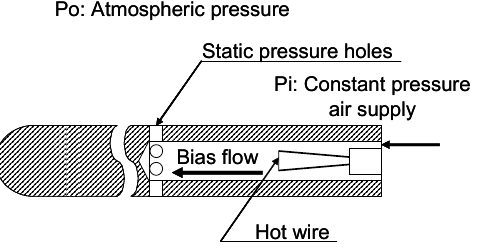
Fig. 1 Cross section of static pressure tube with hot-wire.